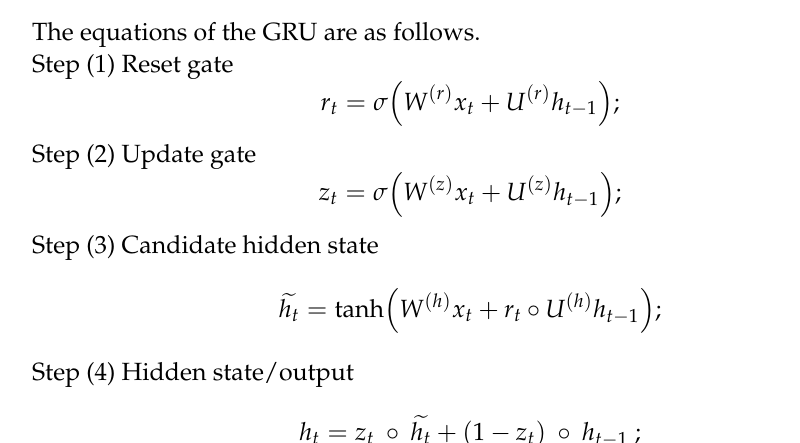
Figure 6. Structure of the GRU.